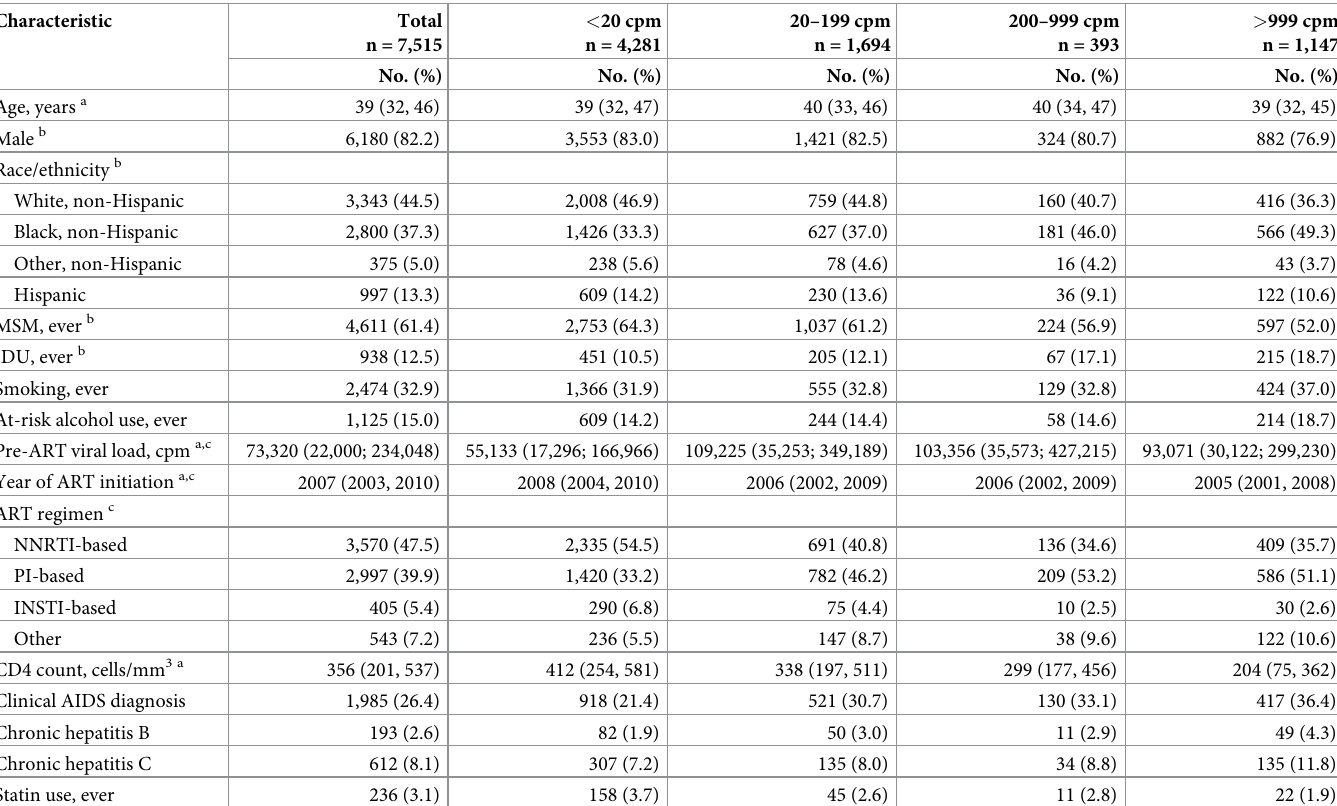
Table 1. Demographic, clinical, and behavioral characteristics of 7,515 CNICS patients six months after ART initiation, averaged over 30 imputations, between 1 July 1998 and 30 June